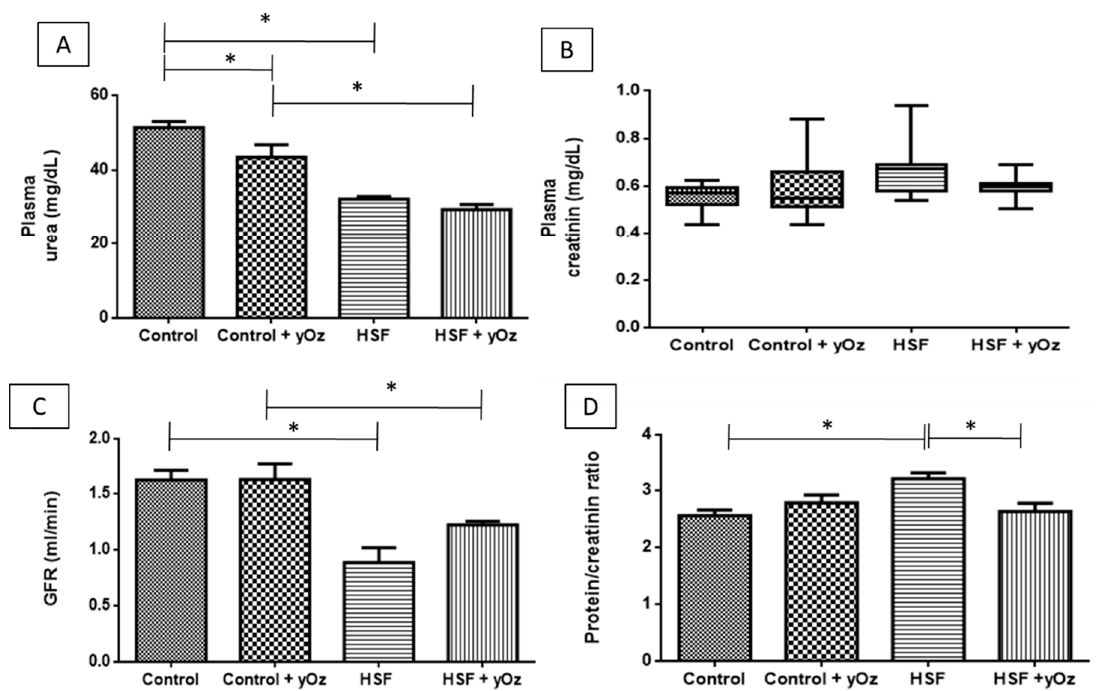
Figure 1. Renal function of animals. ( A ) plasma urea (mg/dL); ( B ) plasma creatinin (mg/dL); ( C ) glomerular filtration rate—GFR (mL/min); and ( D ) protein/creatinin ratio (proteinuria). Data are expressed as means ± standard deviation. Comparison by two-way ANOVA with Tukey post-hoc. HSF—high sugar fat diet. γ Oz—Gamma-oryzanol. * statistically